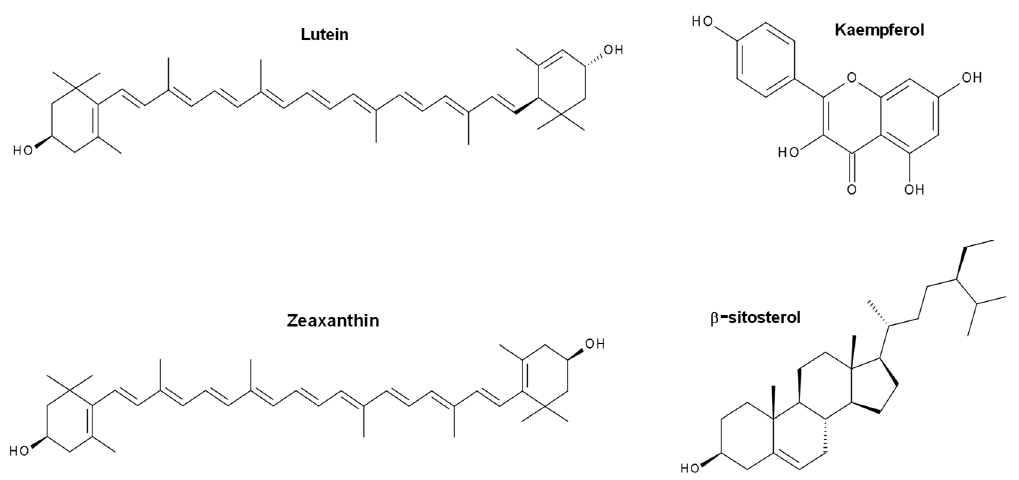
Figure 15. Chemical structure of some of the main components of Tagetes erecta extract.